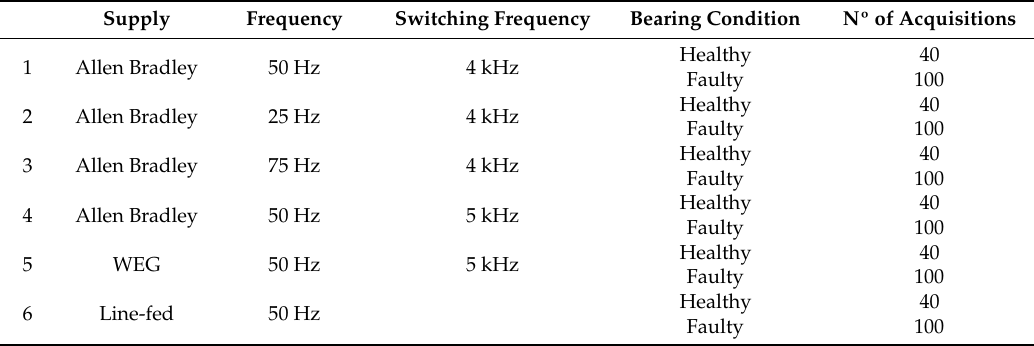
Table 2. Description of test